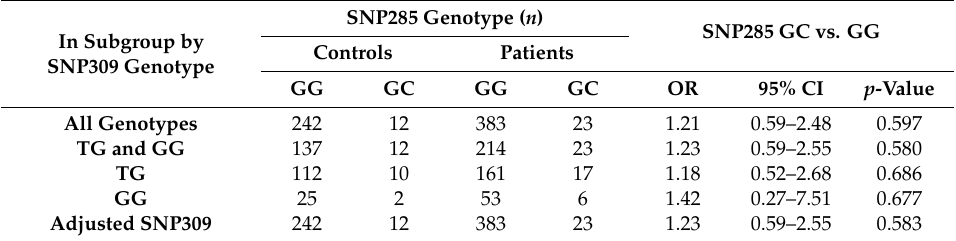
Table 2. Association of MDM2 SNP285 genotypes with breast cancer risk.